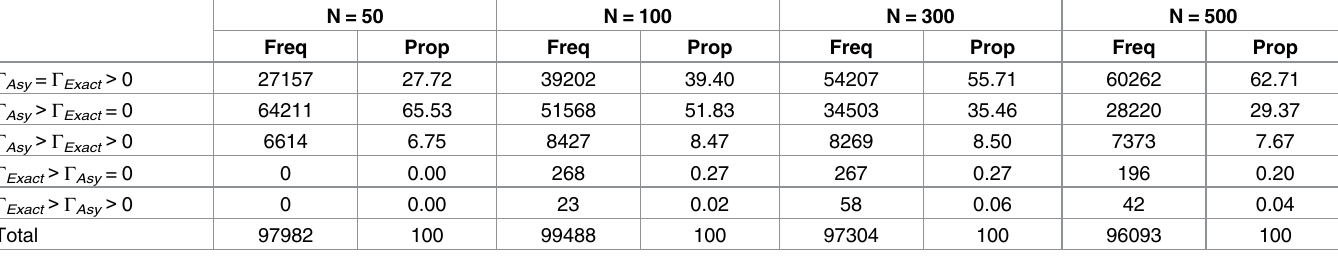
Table 7. For a 3 × 5 contingency table, frequency (Freq) and proportion (Prop) of simulated data having at least one cell is significant based on either T AdjR or exact p-value, from a total of 2 million simulations. Γ Asy and Γ Exact are the numberof cells with significantp-valuesby using the asymptotic approachand the exact approach,respectively.